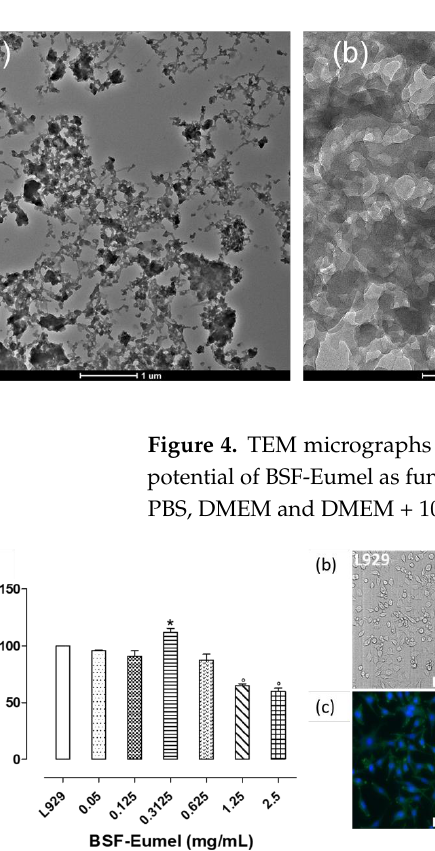
Figure 5. ( a ) Alamar blue cell viability assay (%, normalized to control) performed on L929 cells grown in the presence of BSF-Eumel serial dilution (2.5, 1.25, 0.625, 0.3125, 0.125, 0.05 mg/mL) after 24 h of treatment. Data are presented as mean ± SD. Statistical analysis of variance on mean values is assessed by one-way ANOVA followed by Tukey ’ s post hoc test with multiple comparisons. (* p < 0.05; ° p < 0.001). ( b ) Optical micrographs and ( c ) fluorescent images of L929 with and without BSF- Eumel treatment at 24 h of in vitro cell culture (Scale bar: 500 μm).